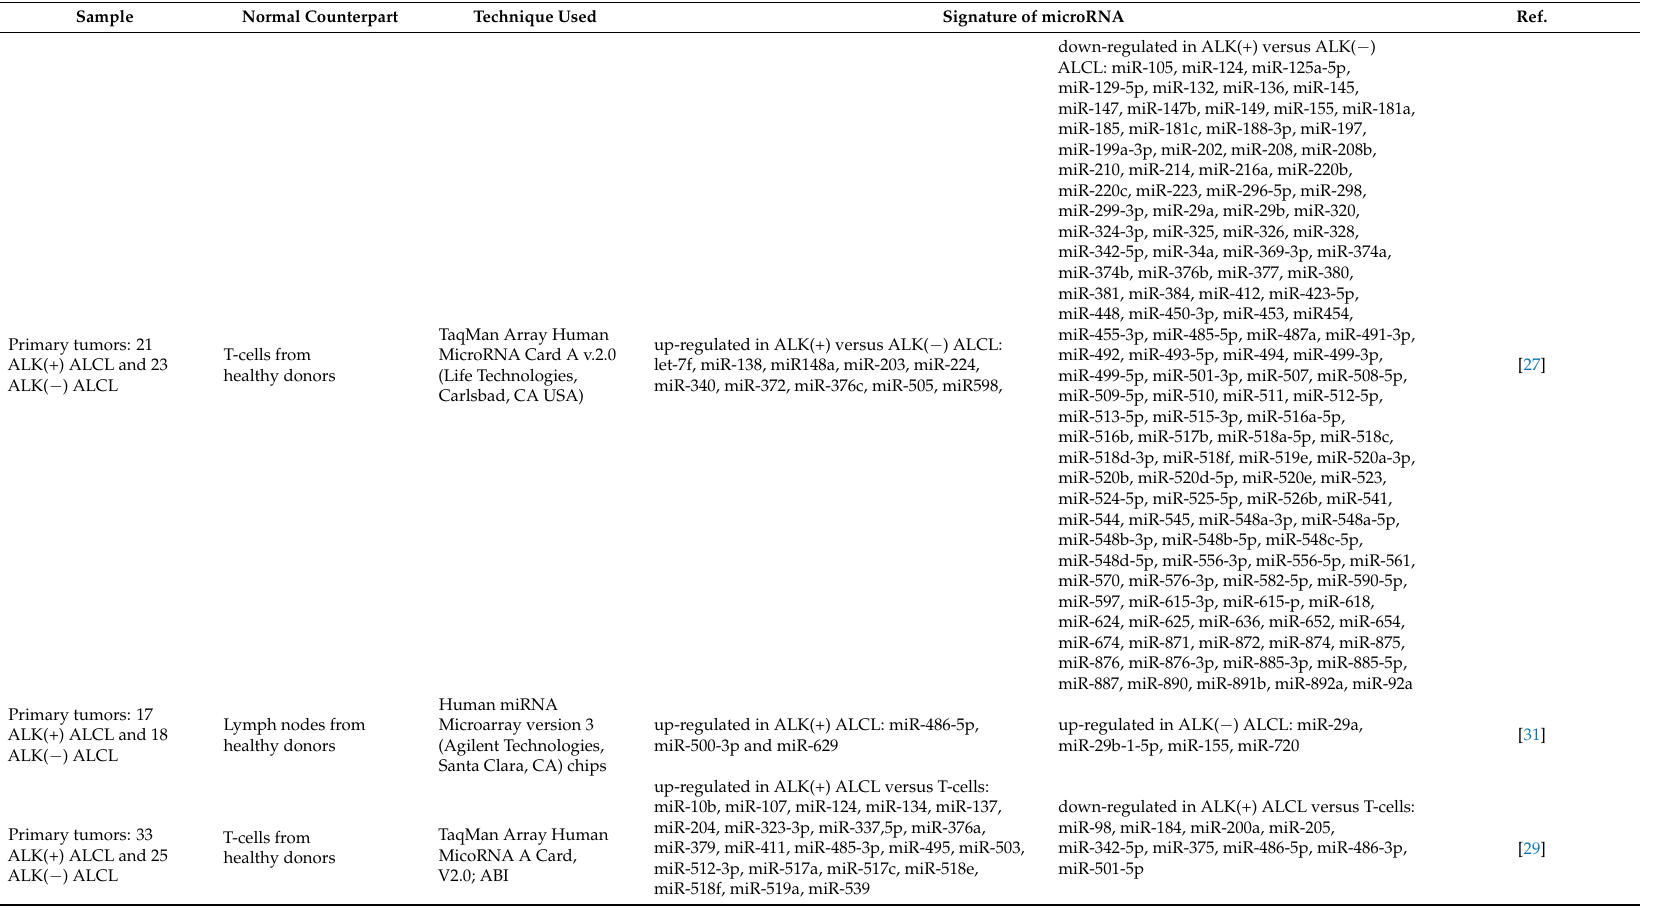
Table 1. Distinct microRNA (miRNA) signatures differentiating in Anaplastic Lymphoma Kinase (ALK), positive from ALK( − ) Anaplastic Large Cell Lymphomas